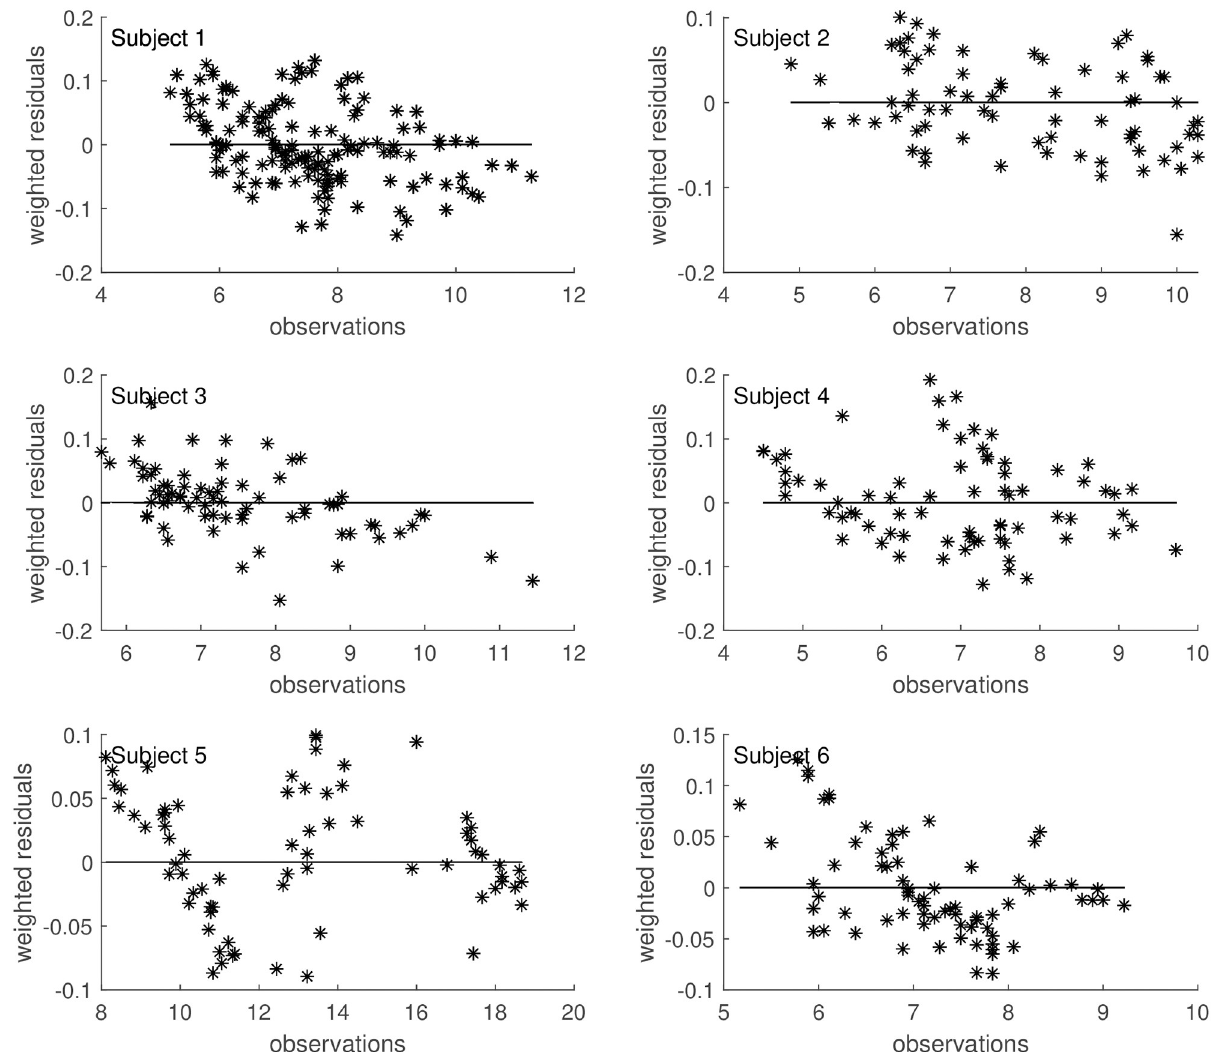
Fig 15. Weighted residuals. Scatter plot of weighted residuals towards observations under the hypothesis of correlated